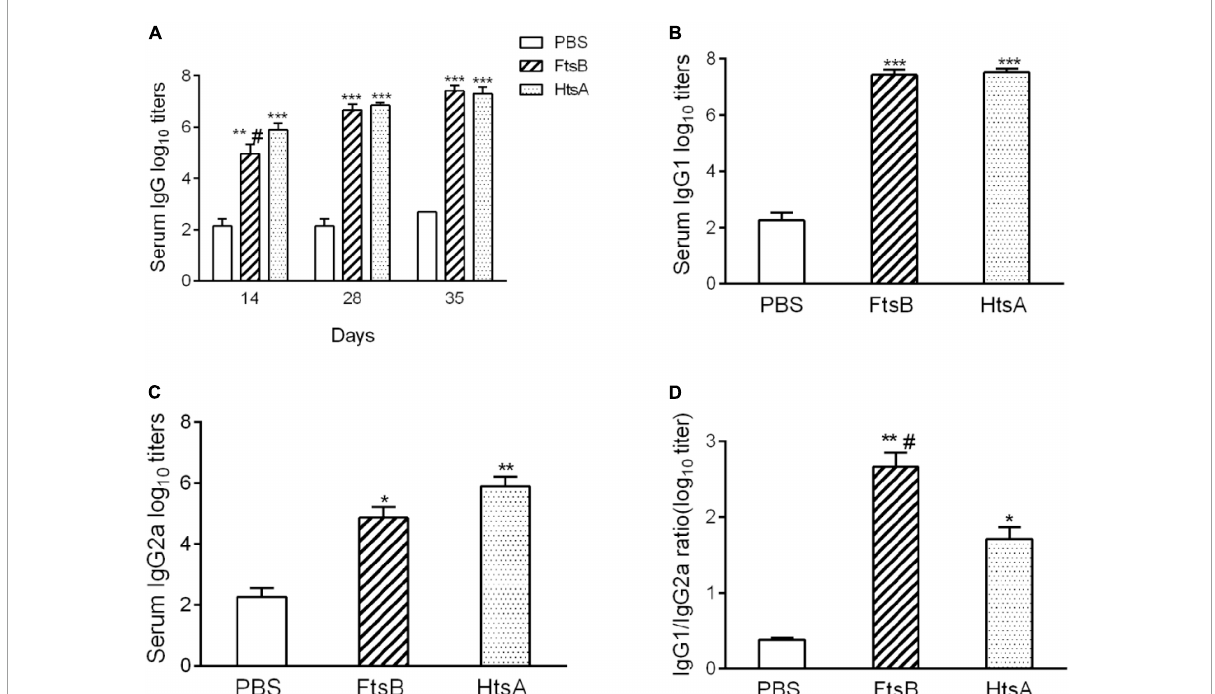
FIGURE2 Antigen-specific antibody responses elicited by FtsB immunization. (A) The level of FtsB-specific IgG antibodies was determined from serum samples on days 14, 28 and 35 by ELISA. (B) The level of FtsB-specific IgG1 was determined from serum samples on day 35 by ELISA. (C) The level of FtsB-specific IgG2a was determined from serum samples on day 35 by ELISA. (D) The ratio of IgG1/IgG2a. n = 10 mice per group, * p < 0.05, ** p < 0.01, *** p < 0.001 vs. PBS control group, # represents p < 0.05 vs. HtsA group. The HtsA protein plus an aluminum adjuvant was used as a positive control, and PBS plus an aluminum adjuvant was used as a negative